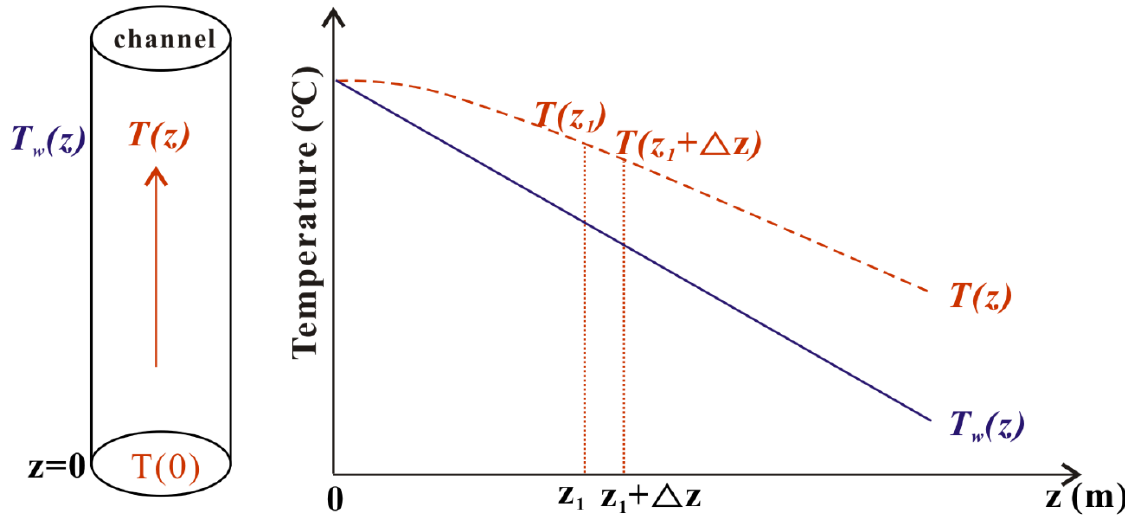
Figure 3. Schematic illustration of temperature changes in the mud volcanic channel.